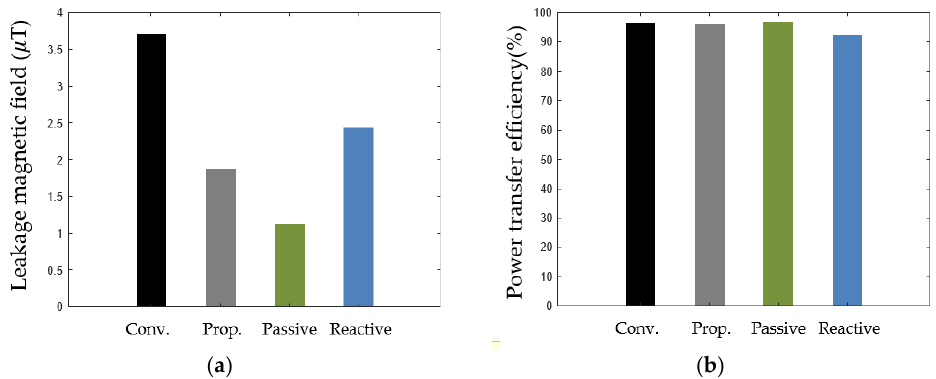
Figure 15. Simulation results of various shielding methods and the proposed method: ( a ) leakage magnetic field level; ( b ) PTE.